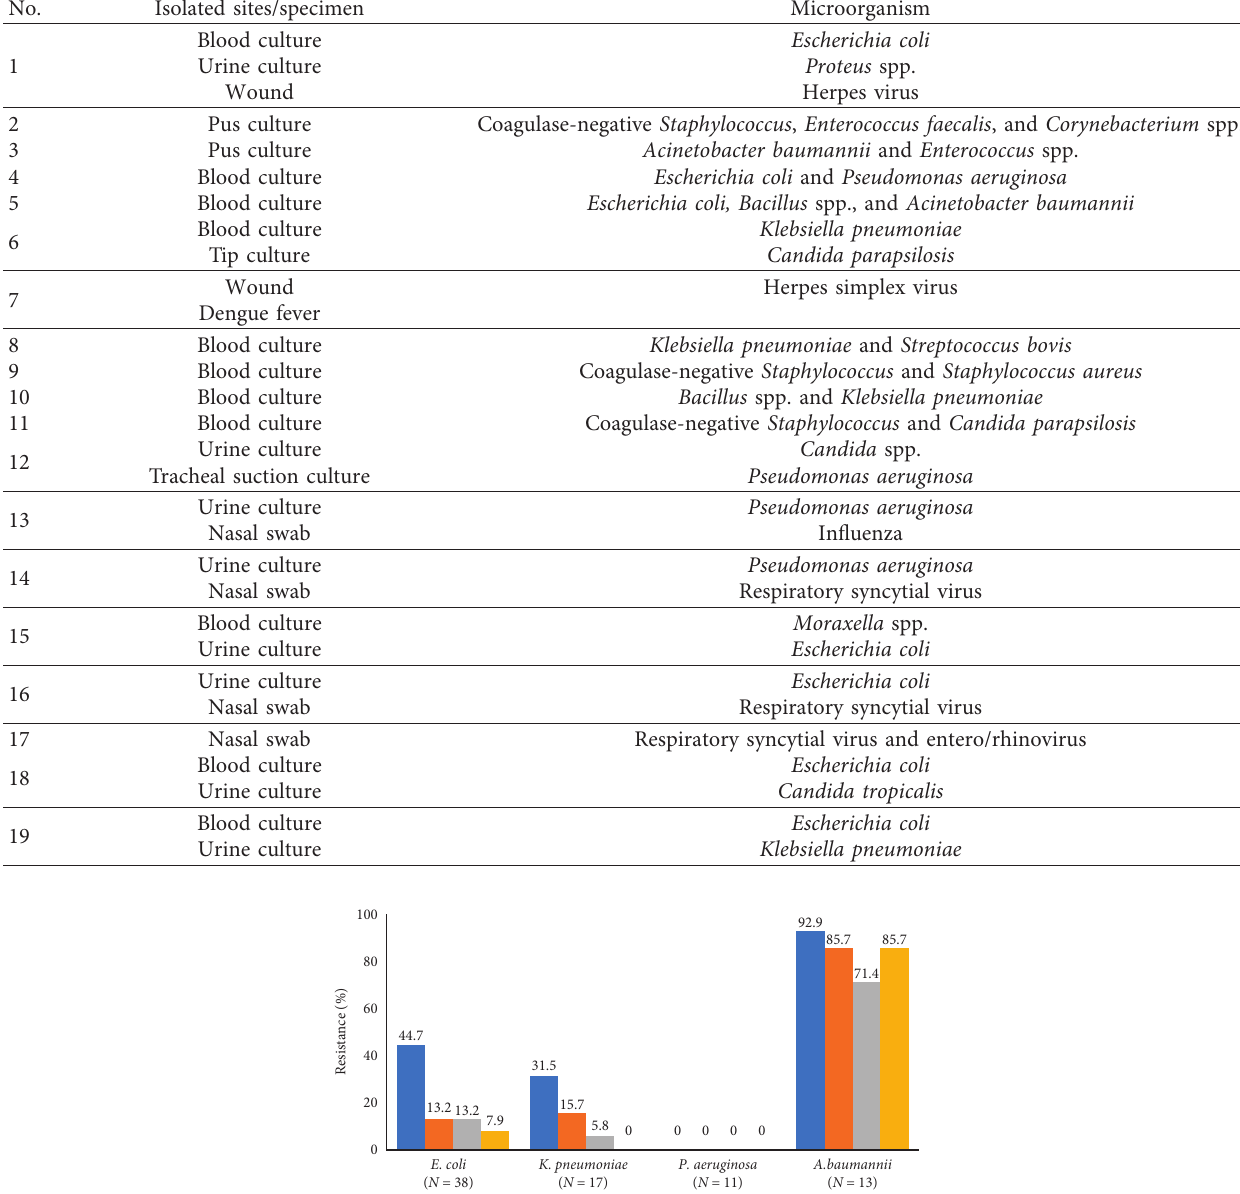
Table 5: Summary of febrile neutropenic episodes with polymicrobial infections.